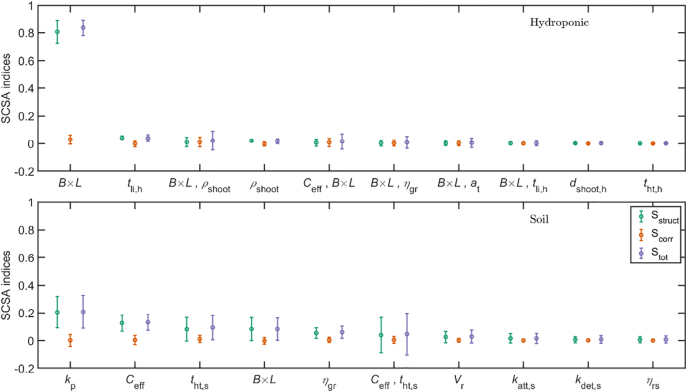
Top 10 most significant SCSA sensitivity indices (mean ± s.d., 100 bootstrapped samples) for hydroponic (top panel) and soil (bottom panel) grown lettuce. Sstruct, Scorr and Stot correspond to Sa, Sb and S in (Li et al., 2010). A comma denotes second order sensitivity terms for pairs of parameters.